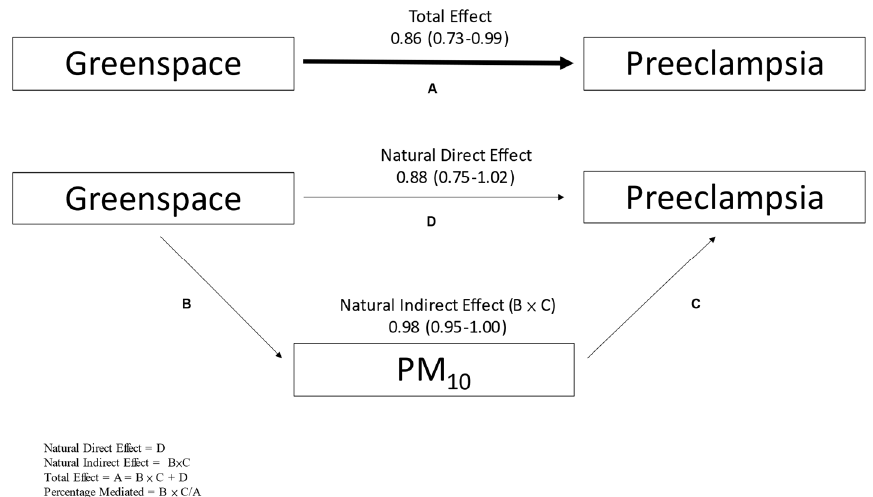
Figure 1. An example of the procedure used for mediation analyses. In this example, PM 10 mediated the association between greenspace and mild preeclampsia by 15%. Table 1. Descriptive characteristics (%) a of 2282 women with preeclampsia by phenotype and 75,124 controls in California from 2000 to 2006.